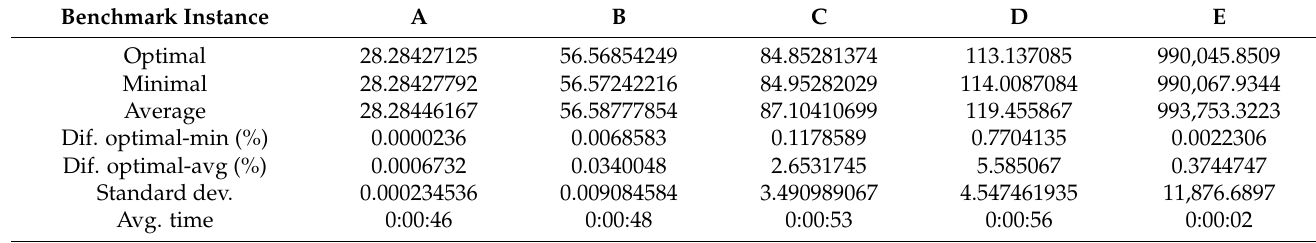
Table 8. Calculations EPC2.